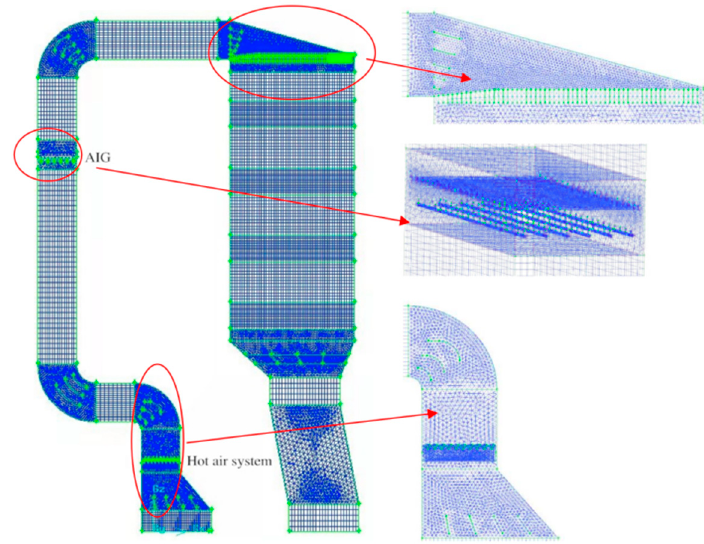
Figure 3. SCR three-dimensional model meshing.